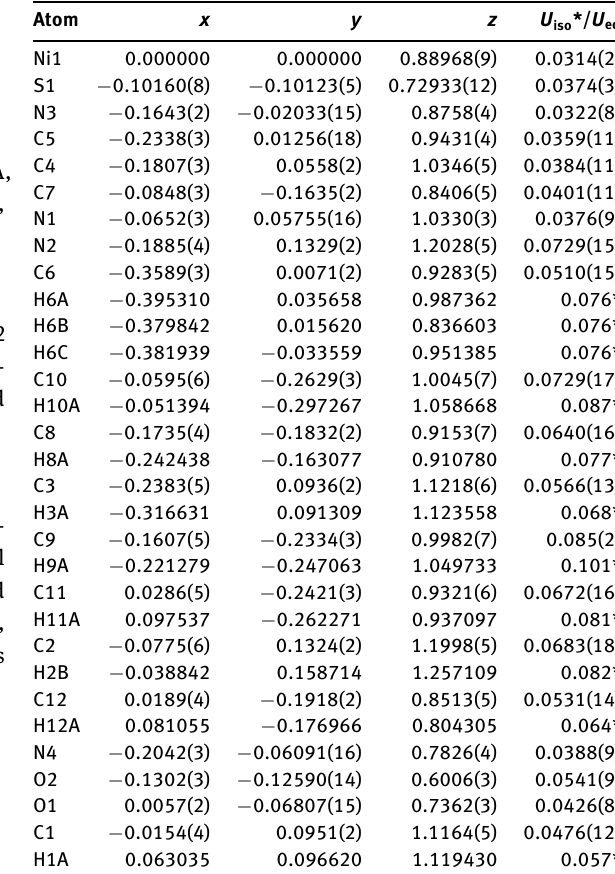
Table 2: Fractional atomic coordinates and isotropic or equivalent isotropic displacement parameters (Å 2